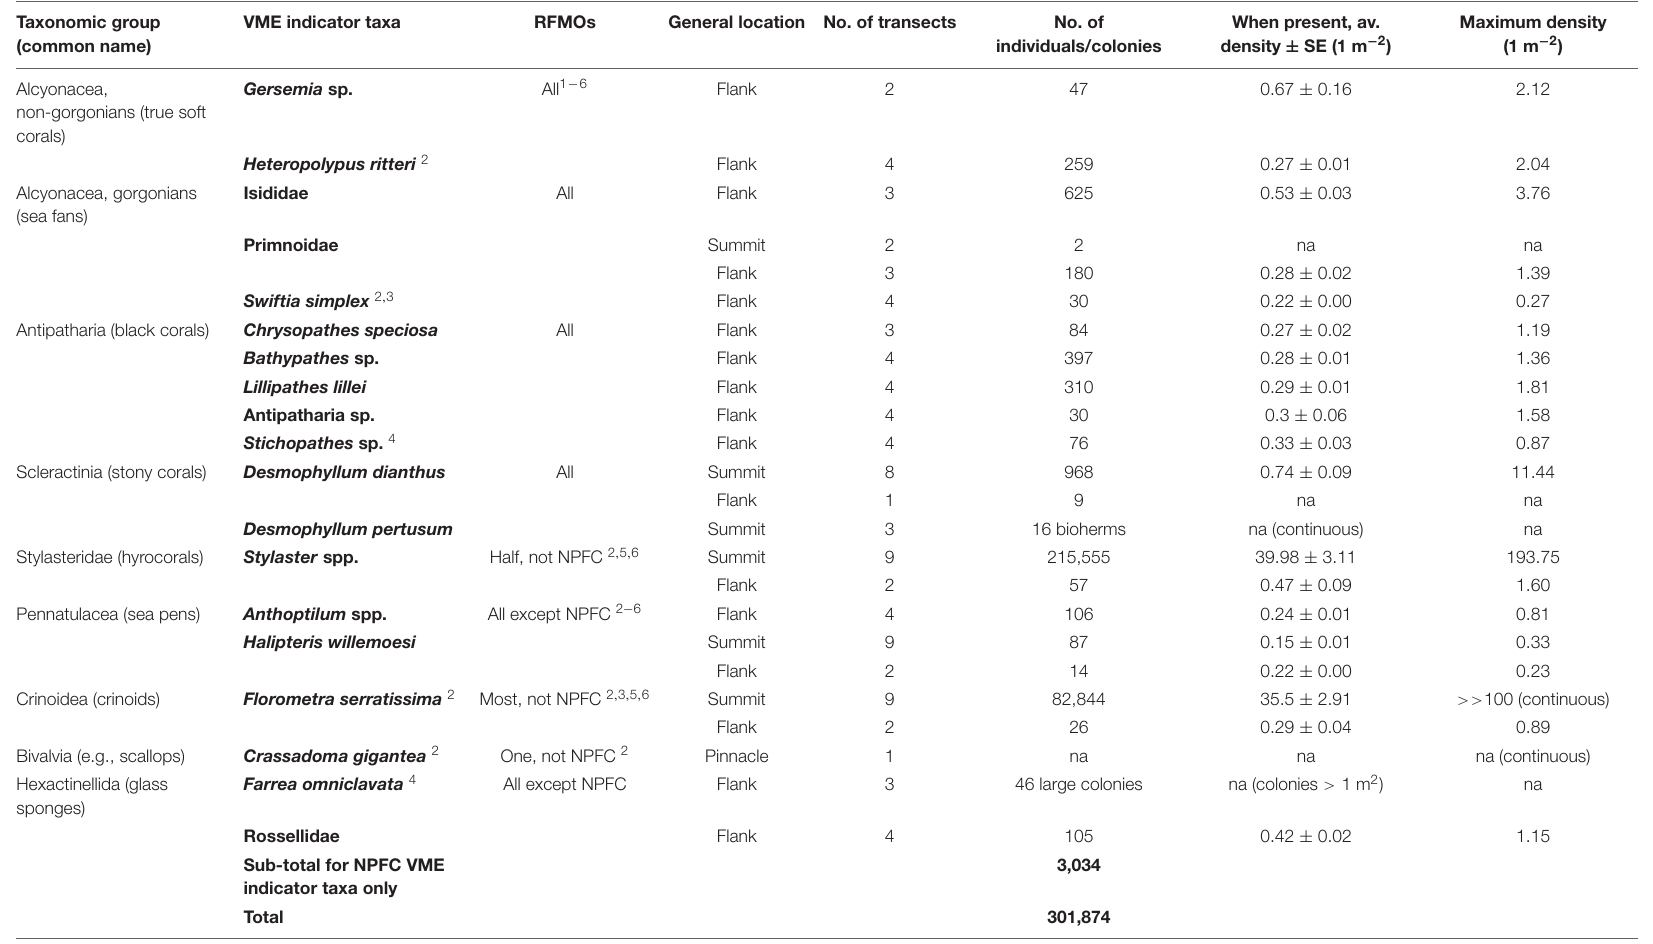
TABLE 1 | The occurrences of 19 groupings of habitat-forming biological structures on Cobb Seamount, observed during a 2012 visual survey. Taxonomic group (common